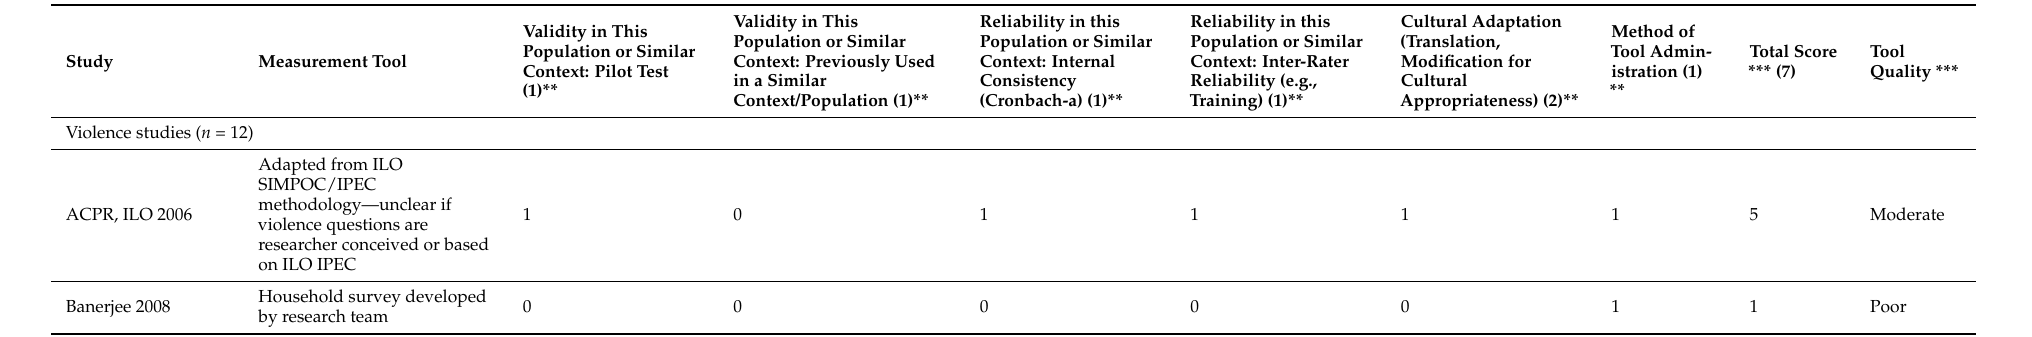
Table A2. Critical appraisal of survey measurement tools of health and violence studies ( n =